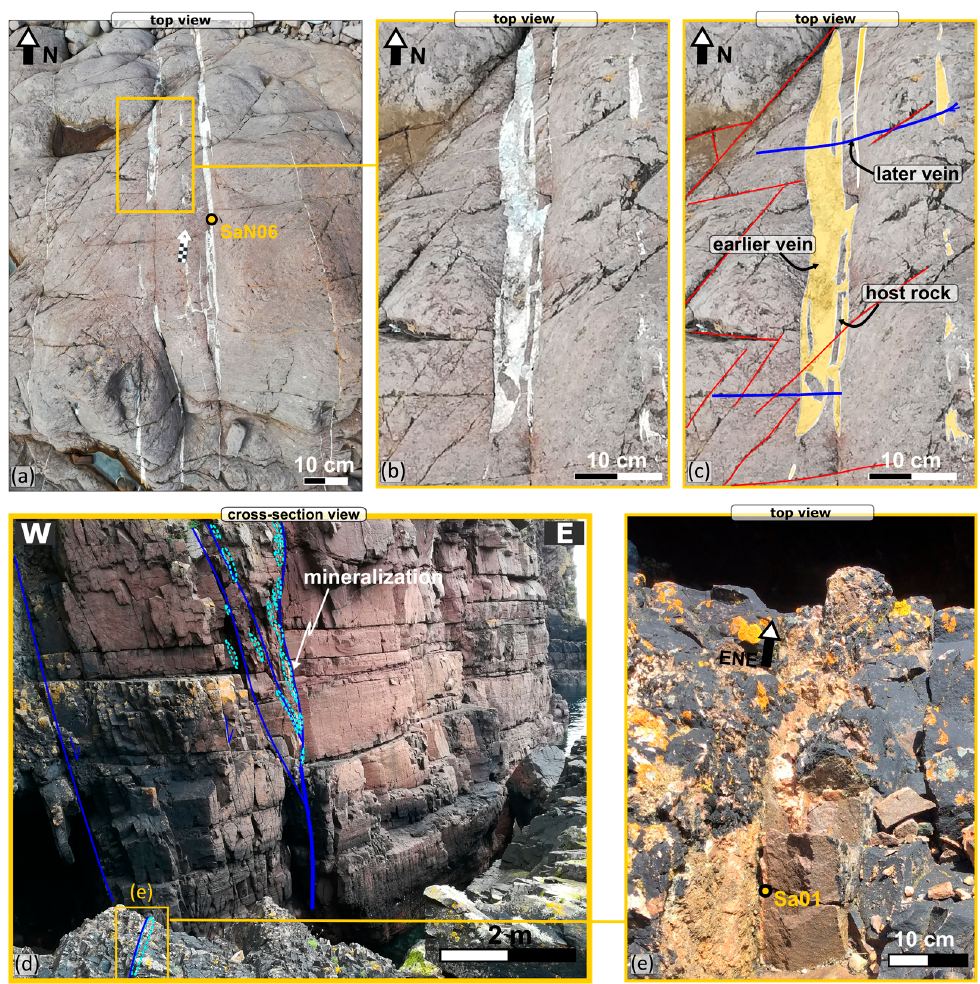
Figure 7. ( a , b ) Field photographs and ( c ) line drawing snowing the N–S-trending calcite mineralised veins with location of sample SaN01 indicated on ( a ). Note the N–S-trending vein is crosscut by a later ENE–WSW-trending vein. ( d , e ) Field photographs showing the later NE–SW-trending faults which are associated with pink-coloured zeolite-calcite-quartz mineralisation. Location of sample Sa01 is indicated in ( e ).